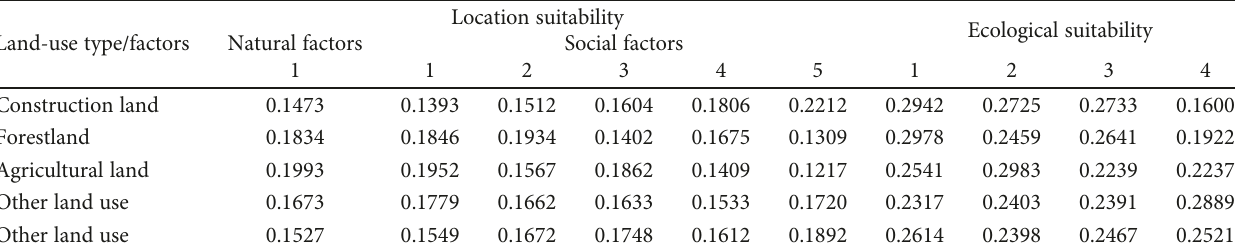
Table 7: Weight settings of each